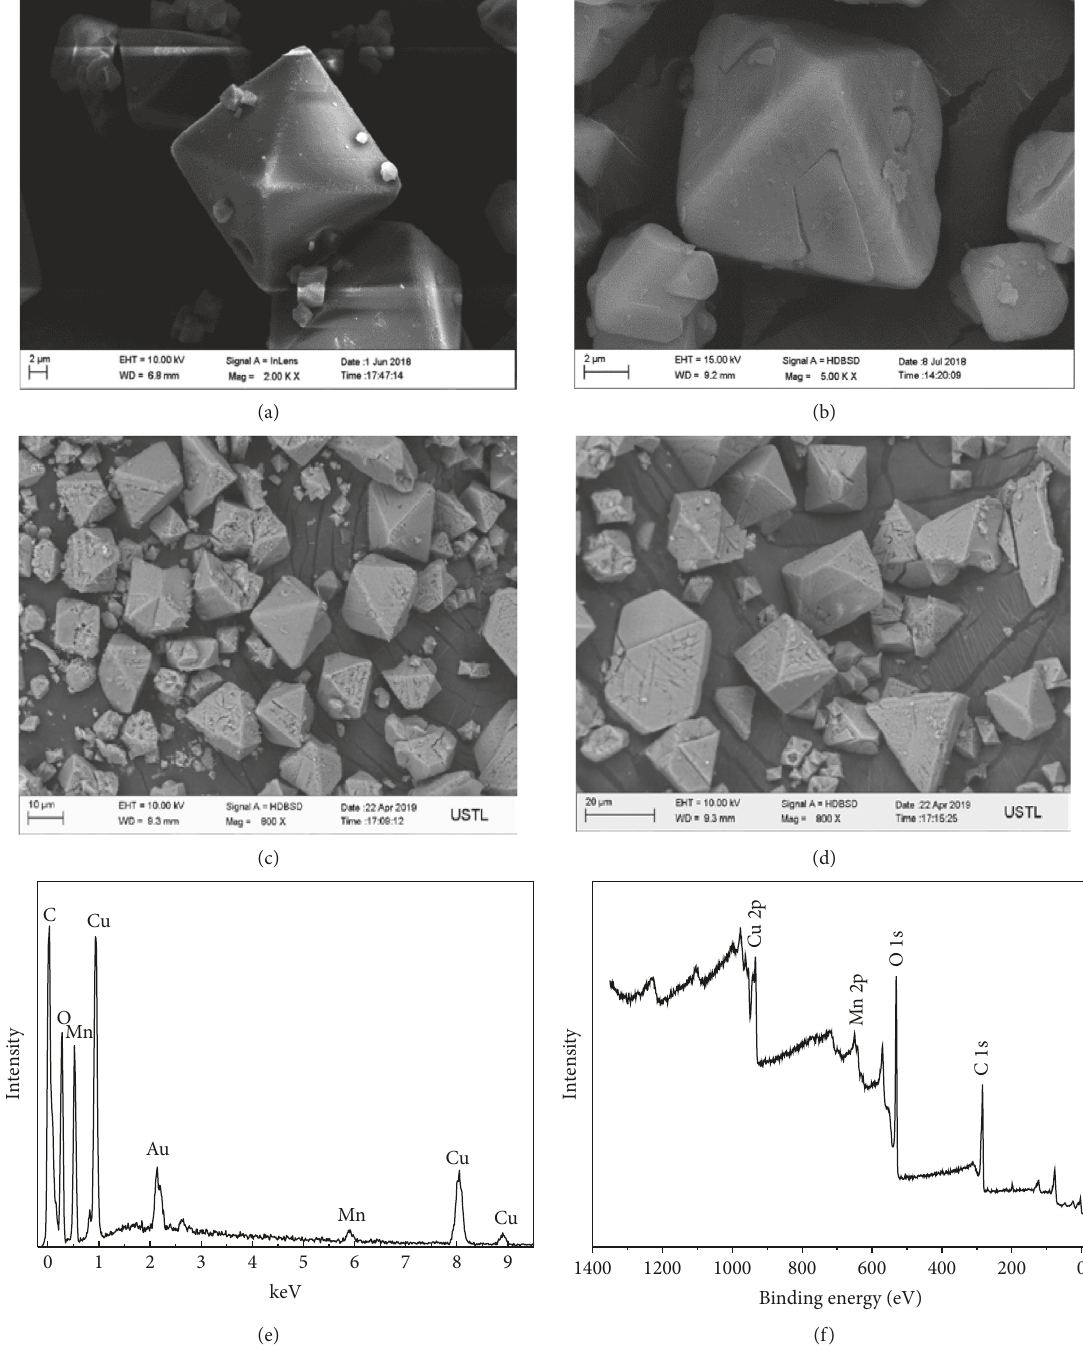
Figure 1: Representative SEM images of (a) as-prepared CuBTC, (b) as-prepared Mn@CuBTC-0.05, (c) activated CuBTC, and (d) activated Mn@CuBTC-0.05; representative survey of (e) EDS spectrum and (f) XPS spectrum obtained from as-prepared